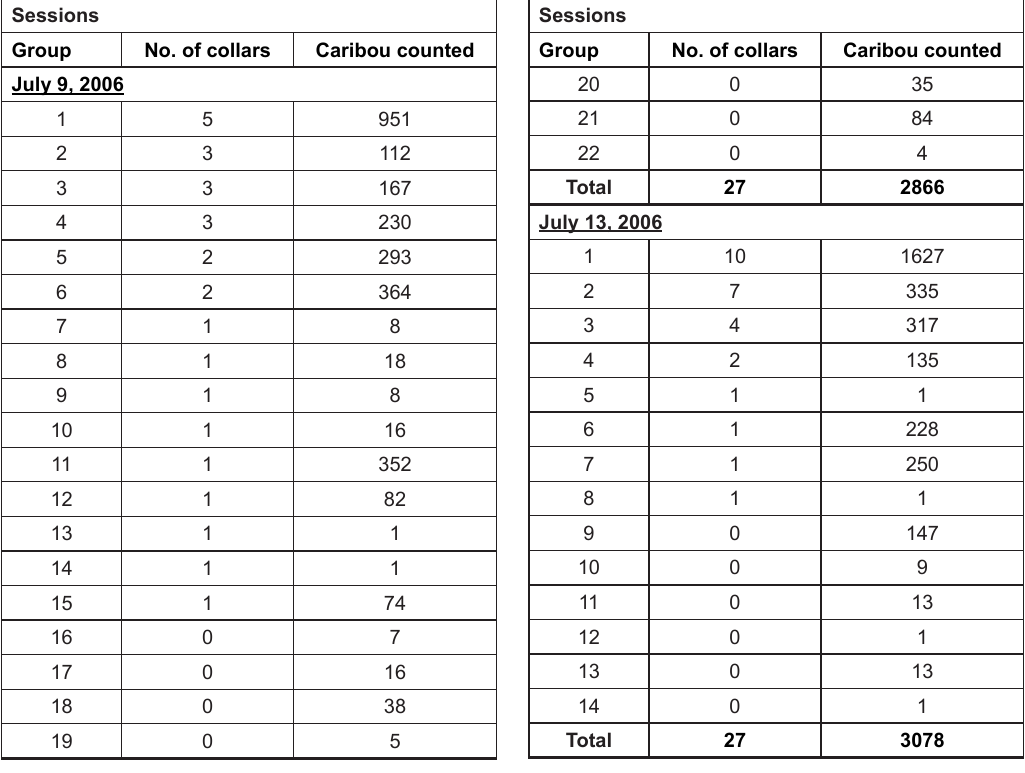
Identical log-likelihood scores and estimates were returned for all models for both survey dates